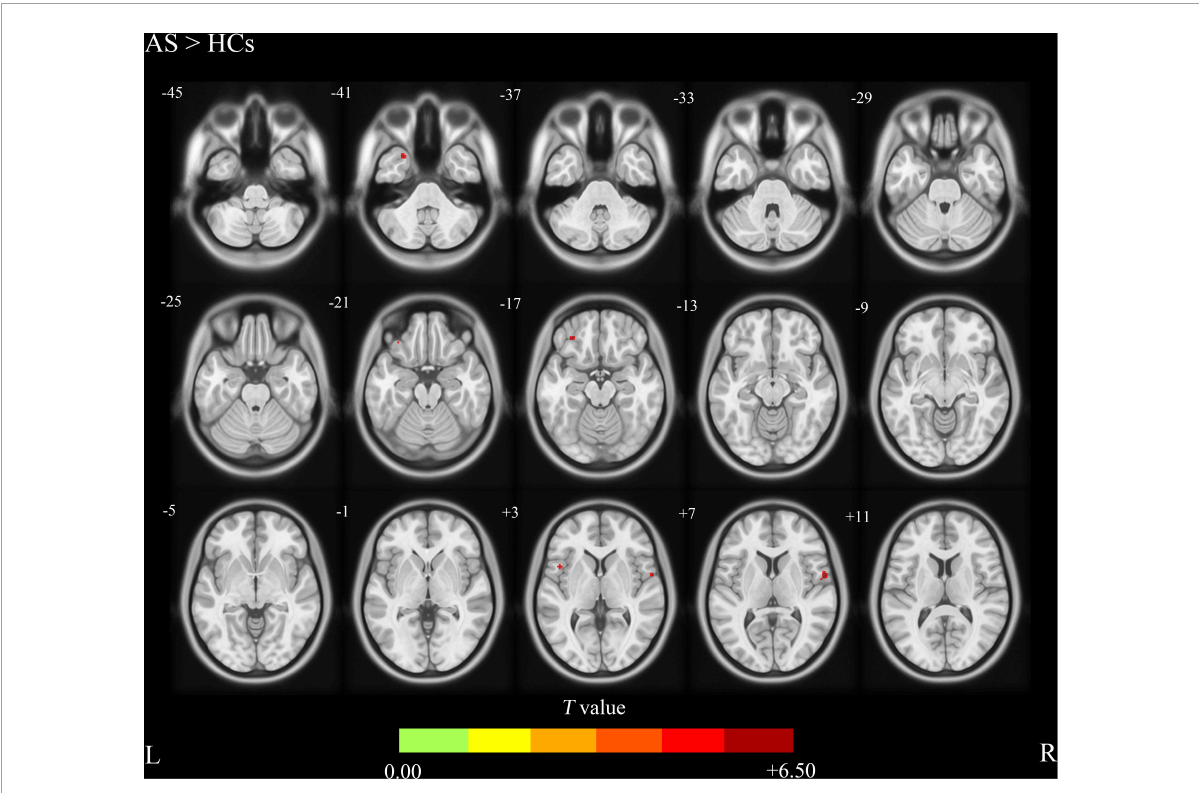
FIGURE1 Ankylosing spondylitis patients showed significantly increased CBF clusters than HCs (voxel-level correction of FWE). AS, ankylosing spondylitis; HCs, healthy controls; CBF, cerebral blood flow; L (R), left (right) hemisphere; The color bar indicates the T value from the two-sample t -test.